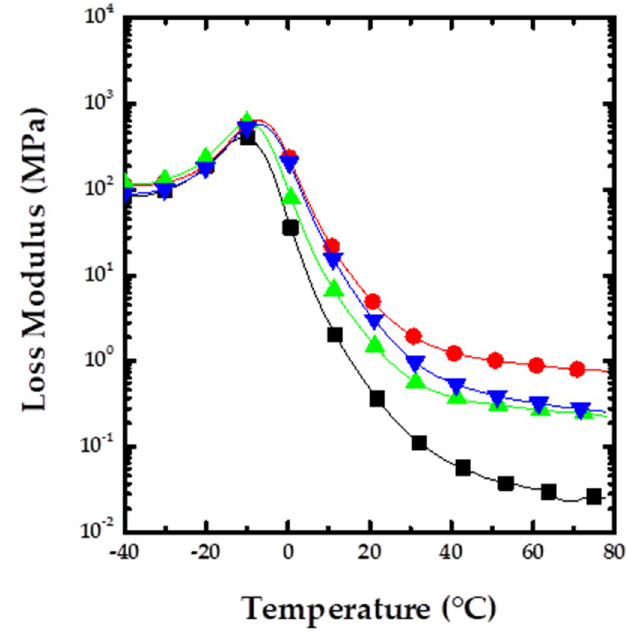
Figure 2. Loss modulus (E’’) vs. temperature for V-SBR-REF-0 ( ■ —black line), V-SepS9/SBR (●—red line), V-NS-SepS9/SBR ( ▲ —green line), and V-NS-SilSepS9/SBR ( ▼ —blue line).